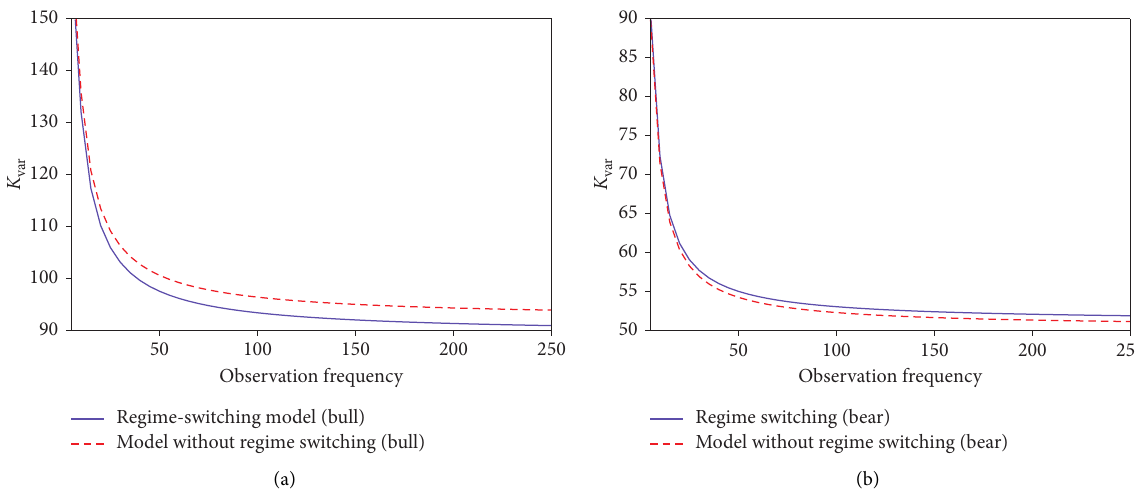
Figure 5: Comparison of K